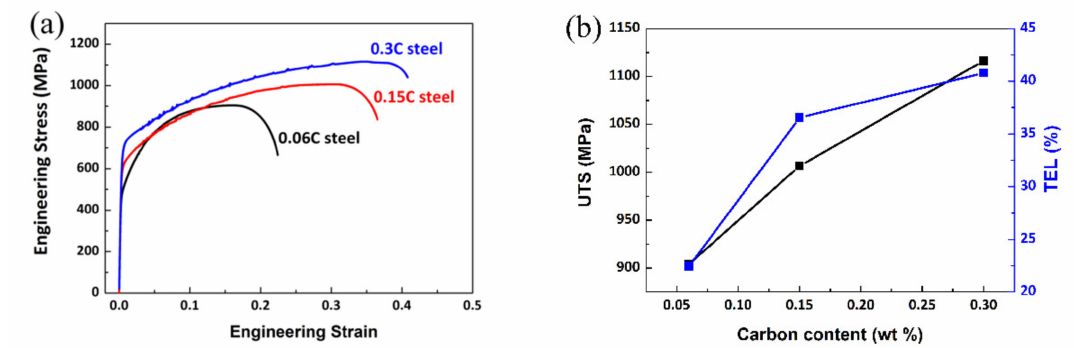
Figure 5. Mechanical properties of the experimental steels. ( a ) Engineering strain-stress curves. ( b ) Tensile properties of the experimental